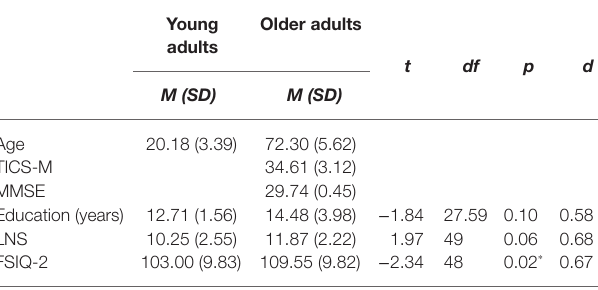
TABLE 1 | Mean scores and SDs of cognitive measures for young adults ( n = 28) and older adults ( n = 23). Young Older adults